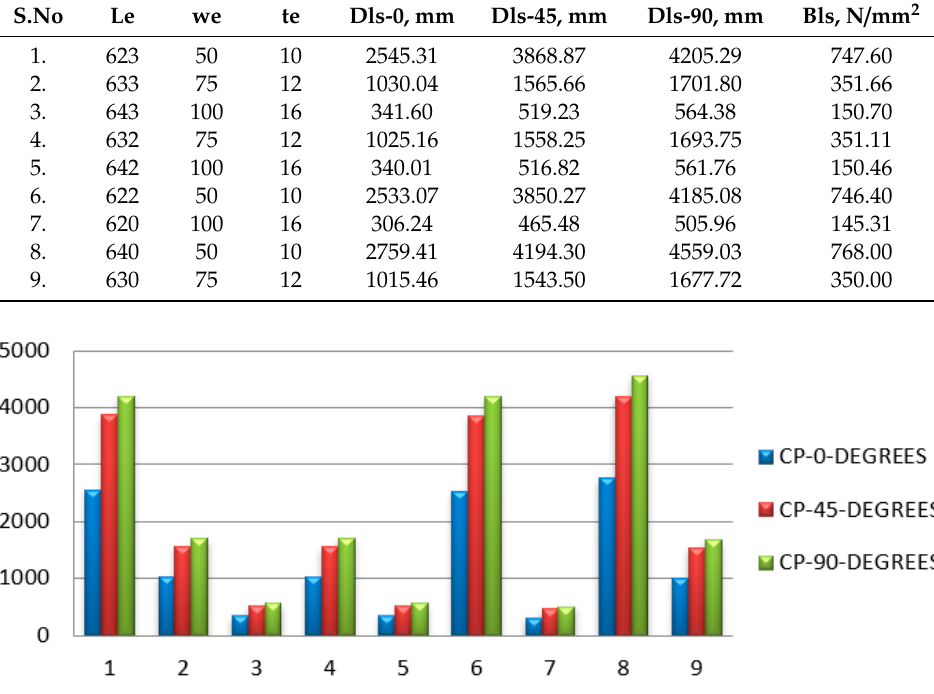
Figure 13. Comparison of deflection with different fiber orientation. Table 6. Maximum deflection of different carbon PEEK fiber orientations.